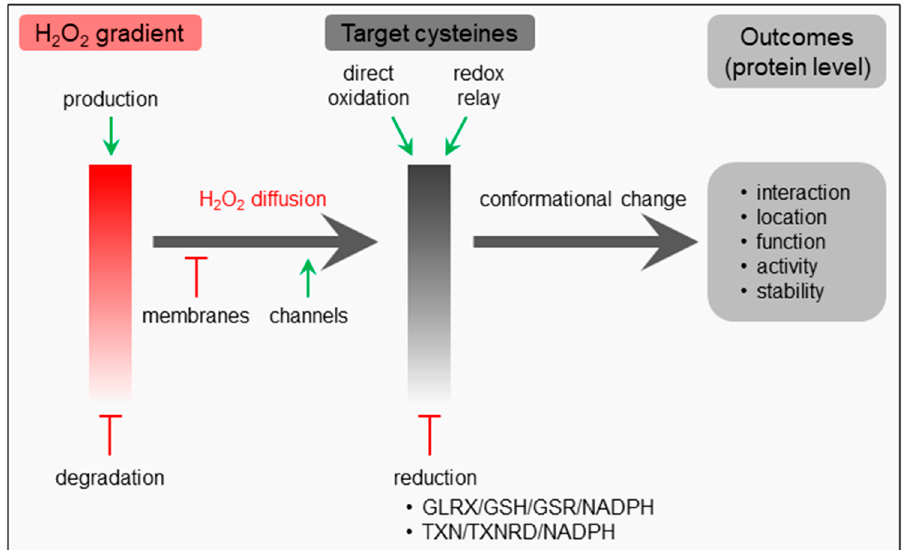
Figure 1. General principles of H 2 O 2 signaling. GLRX, glutaredoxin; GSH, reduced glutathione; GSR, glutathione-disulfide reductase; NADPH, nicotinamide adenine dinucleotide phosphate (reduced); TXN, thioredoxin; TXNRD, thioredoxin reductase.